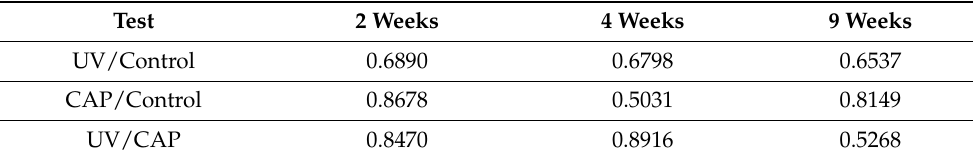
Table 3. Statistical results of the generalized linear mixed model (GLMM) concerning differences in BIC values between the different treatment groups.